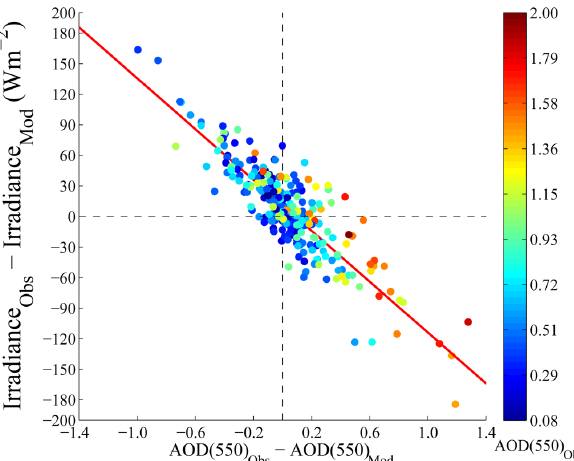
Fig. 8. Difference between downward observed and modeled sur- face solar irradiance versus difference between observed and mod- eled aerosol optical depth (AOD) as a function of observed AOD under cloud-free